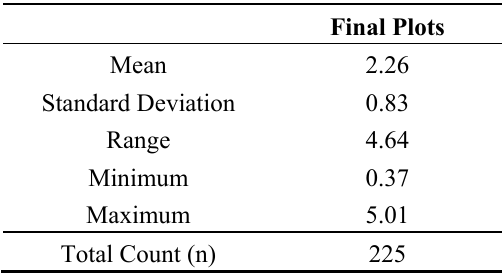
Table 3. Leaf Area Index (LAI) statistics for final